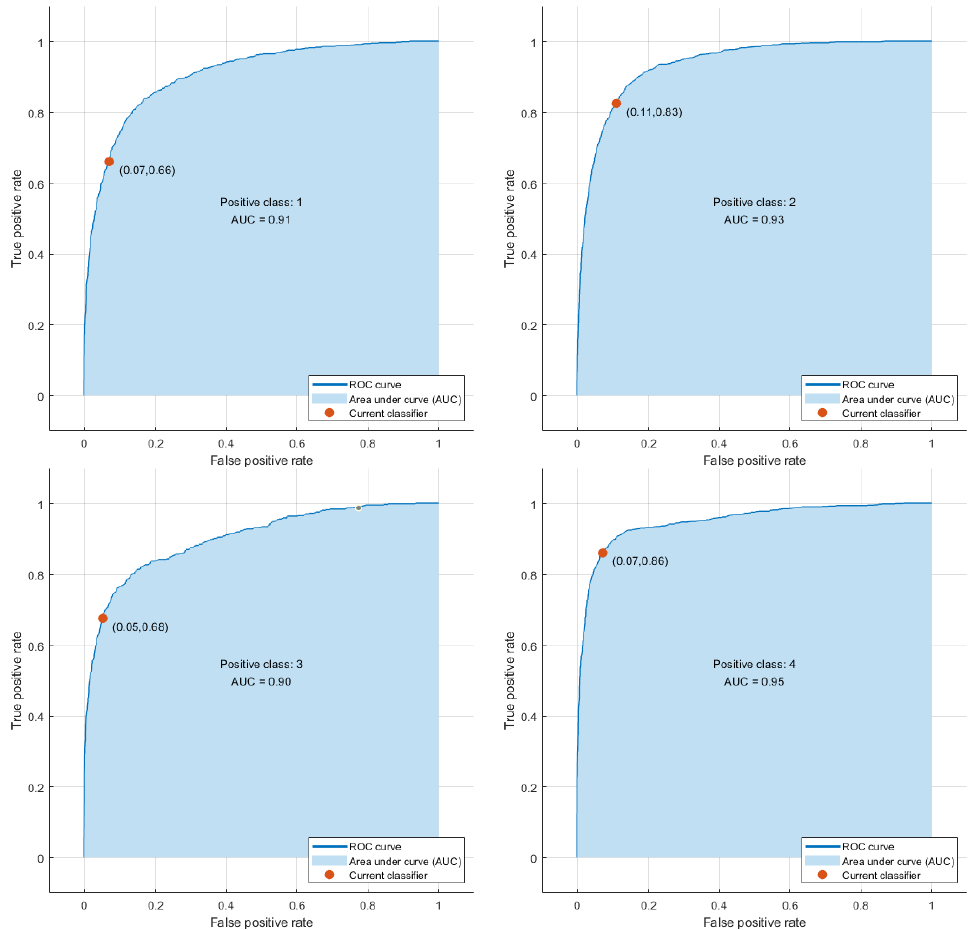
Figure A6. ROC curves of neural